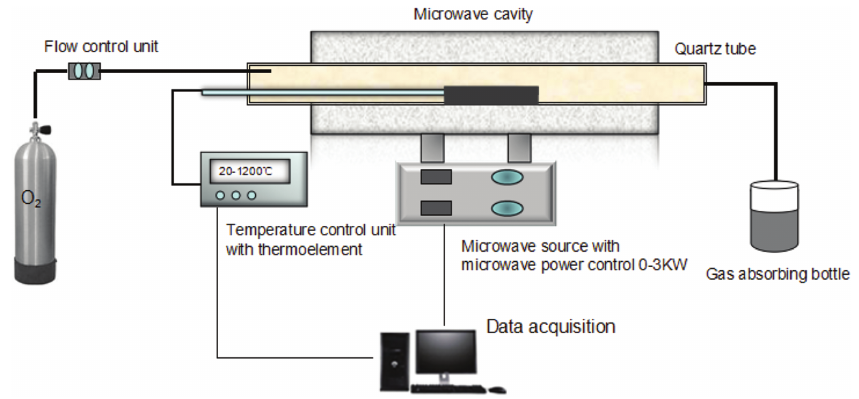
Figure 4: Schematic of the microwave oven used in this work.